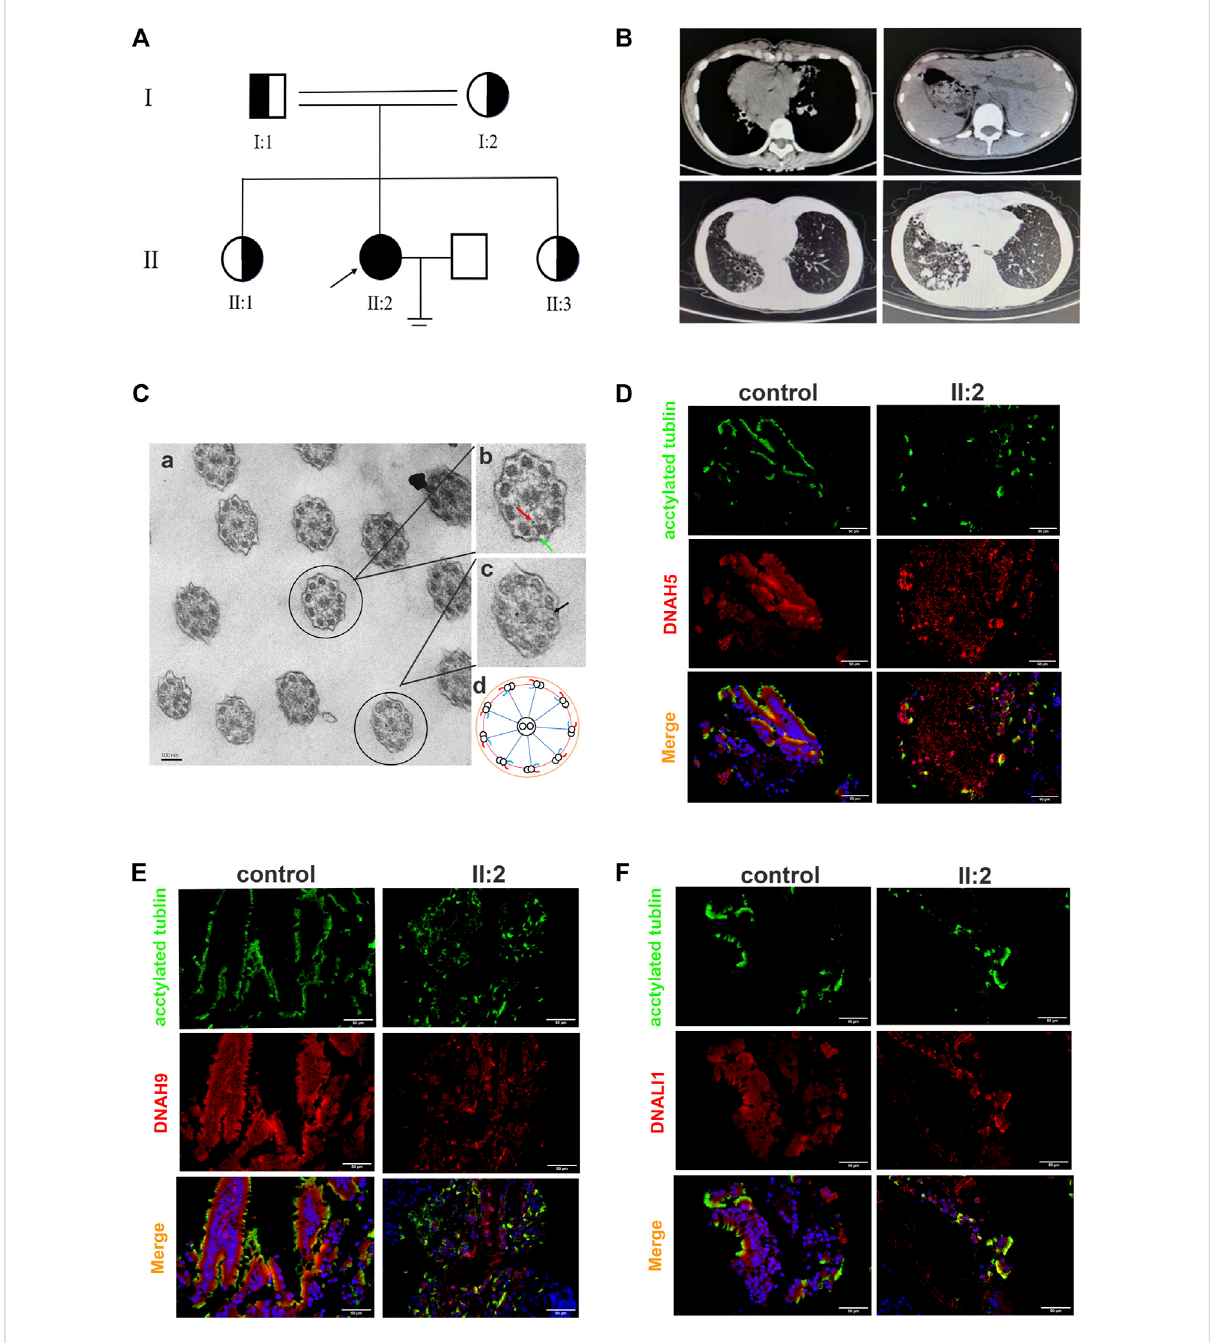
FIGURE 1 PedigreeofthefamilywithPCDandtheclinicalfeaturesoftheprobandfromthisfamily. (A) Thereisonepatient(theproband)inthefamilywith PCD. Circles indicate to females. Squares indicate males. Solid symbols indicate patients. Half solid symbols indicate carriers of the identi fi ed mutations. The arrow indicates the proband. (B) Chest CT scan of the proband showed complete situs inversus, bronchiectasis and Recurrent bronchitisandpneumonia. (C) Thetransmissionelectronmicrograph(TEM)ofbronchialciliaryepitheliumfromtheproband.Theredarrowand the green arrow represent IDAs and ODAs, the black arrow indicates absence of IDAs and ODAs (A – C) . A schematic diagram of the bronchial ciliary epithelium cross-section (D) . (D – F) Immuno fl uorescence of bronchial ciliary epithelium revealed the existence of DNAH5, DNAH9 and DNALI1 of proband. Anti-acetylated tubulin monoclonal antibody was used to mark the ciliary axoneme. DNAH5 and DNAH9 were used to label the outer dynein arm (ODA), DNALI1 was used to label the inner dynein arm